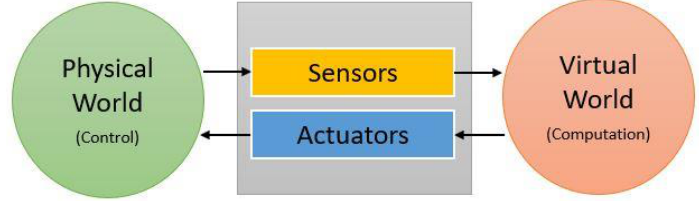
Figure 1. Basic cyber-physical system (CPS) structure.